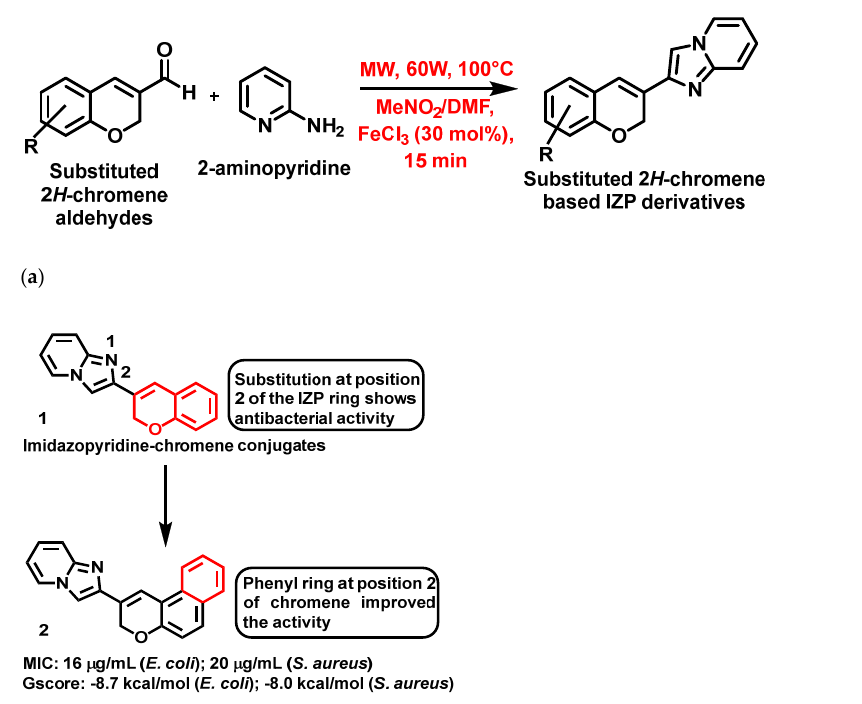
Figure 3. ( a ) General synthetic scheme of 2H-chromene based IZP derivatives. Signatures of com- pounds according to Mishra et al., 2021 [57]. ( b ) 2H-Chromene-based imidazopyridines with a brief SAR. Signatures of compounds according to Mishra et al., 2021 [57].